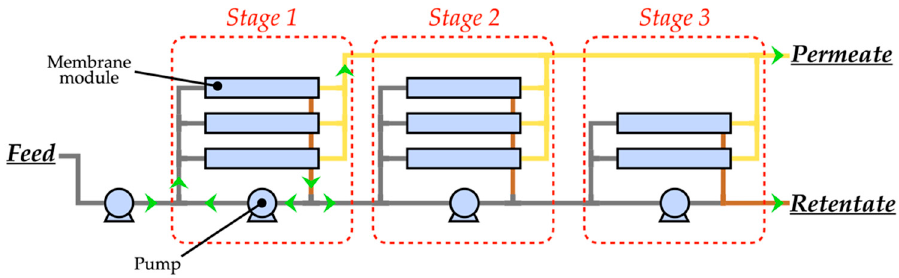
Figure 4. Process flow diagram of the multistage filtration units of scenarios A and B.